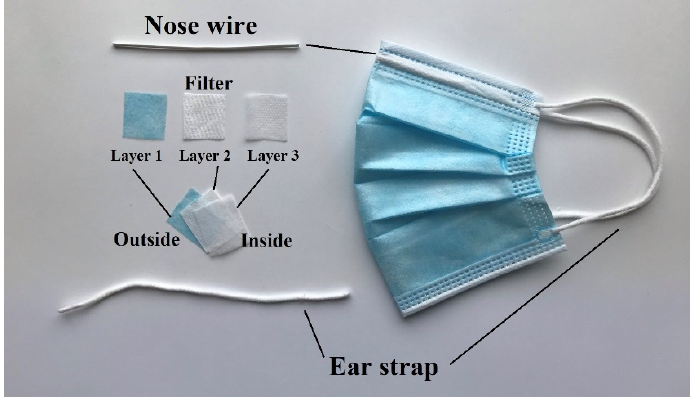
Figure 2. View of disposable protective mask used for studies.